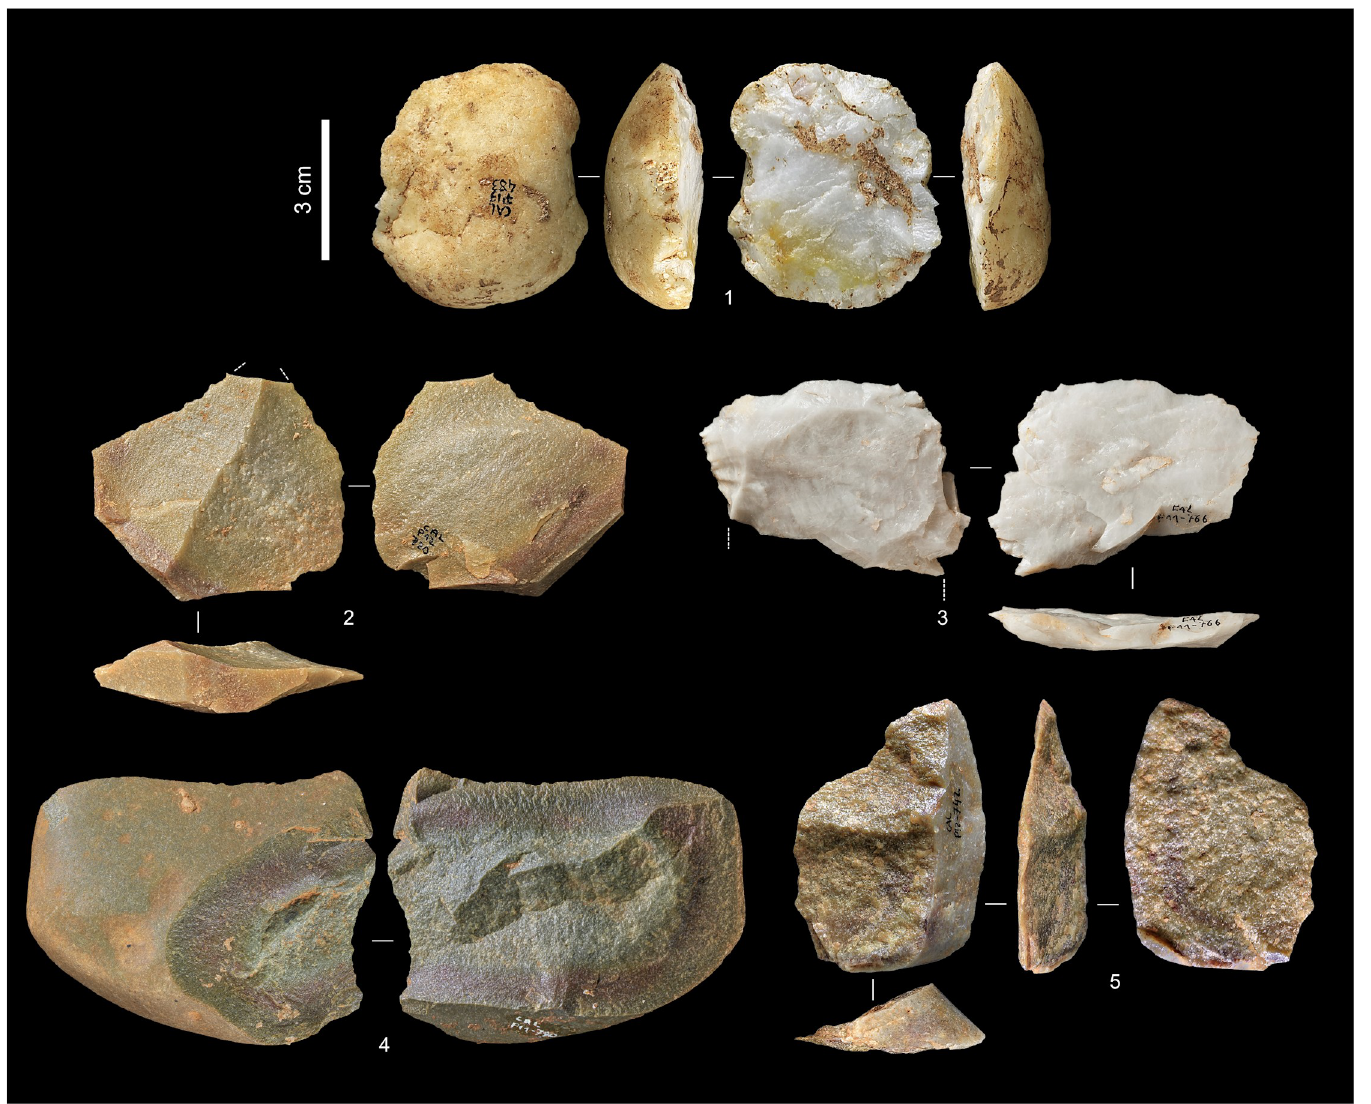
Fig 9. Non-chert de´bitage from layers Jb-L. 1. Cortical flake, quartz (P13-483, layer L). 2. Flake with distal-marginal micro-denticulation of the edges (use-wear?), quartzite (P12-720, layer K). 3. Levallois flake, distal fragment, quartz (P11-766, layer K). 4. Flake, quartzite (P11-790, layer K). 5. Flake, quartzite (P12-742, layer